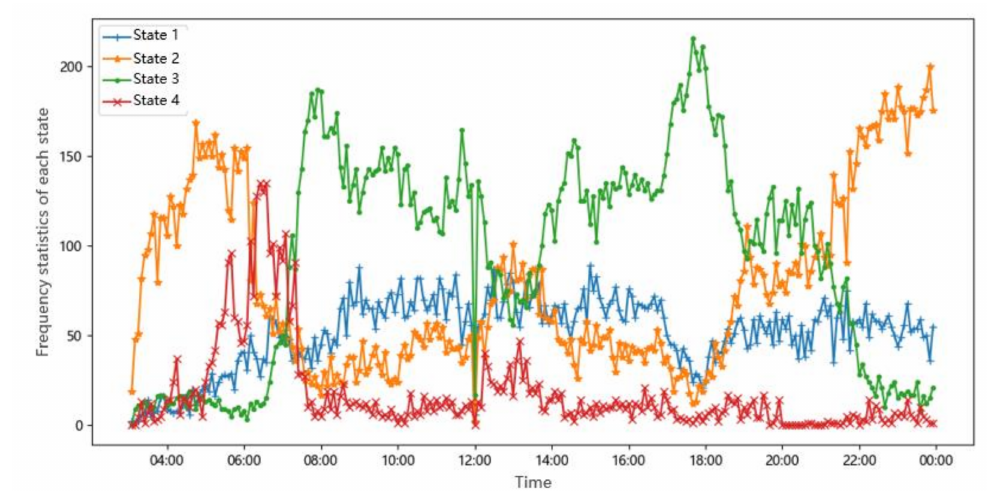
Figure 6. Clustering results of k = 4